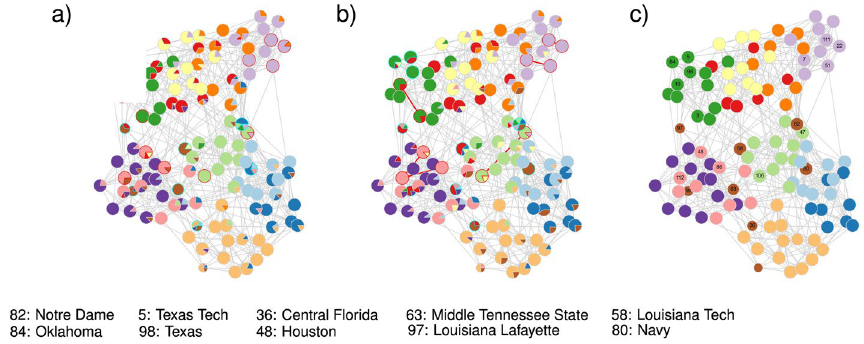
Fig. 7 The network of American college football after addition of edges (Experiment 3). a The communities inferred by CD on the original input data. b Community detection by CD algorithm on the dataset after addition of the potential inferred edges inferred by ACD (these edges are shown in red). c Ground truth communities. The nodes that changed their communities between a and b are shown with cyan border. Those with red border are nodes connecting to added edges. The name of some of the nodes impacted by the edge addition is added to the figure as the footnote